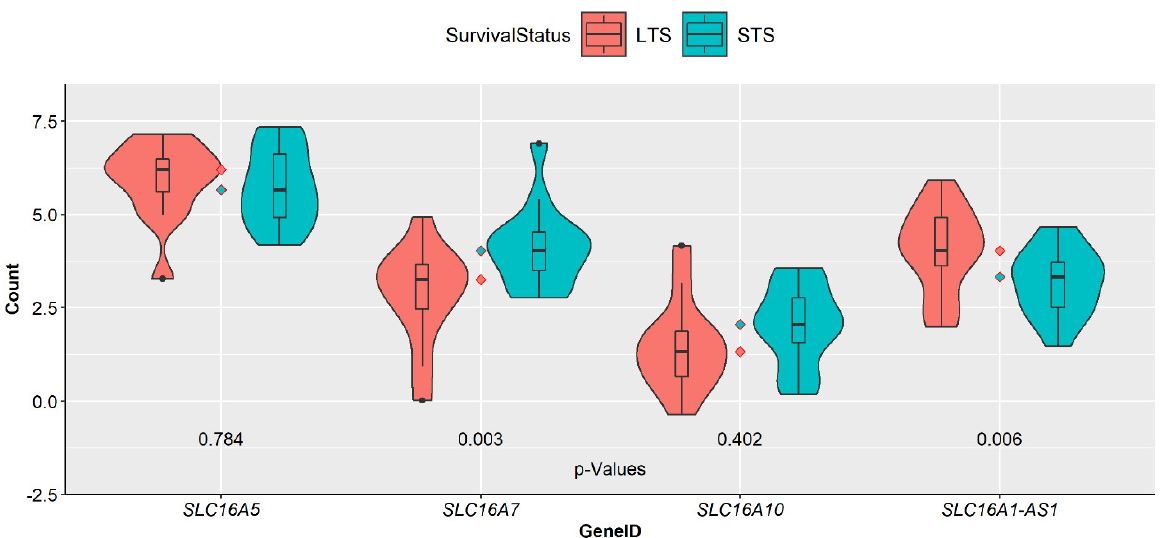
Figure 4. Log-normalised levels of MCT transcripts SLC16A5 /MCT6, SLC16A7 /MCT2, SLC16A10 /MCT10, and SLC16A1-AS1 in short- and long-term survivors (STS and LTS, respectively) from the GSE79668 dataset. These four genes are the top 4 differentially expressed MCTs in PDAC stroma–epithelium (FDR < 0.05) from the GSE93326 dataset, hence the rationale for selecting them for investigation in the GSE79668 dataset. The number of samples from STS and LTS subjects are 14 and 13, respectively. The indicated p -values are not FDR-adjusted. Of the four MCTs investigated, SLC16A7 and SLC16A1-AS1 were significantly upregulated in STS and LTS subjects, respectively, with the other two MCTs showing similar expressions in both survival groups ( p < 0.05).